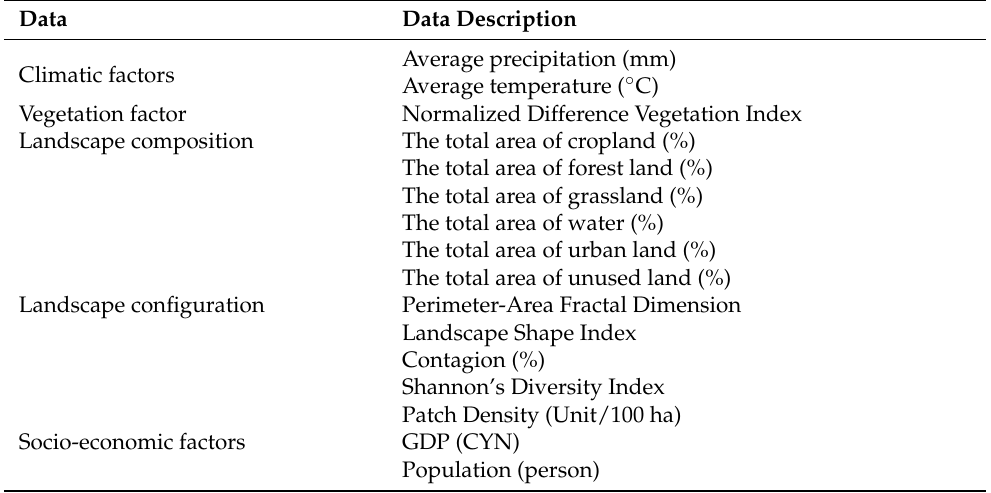
Table 2. Description of potential driving factors investigated in this